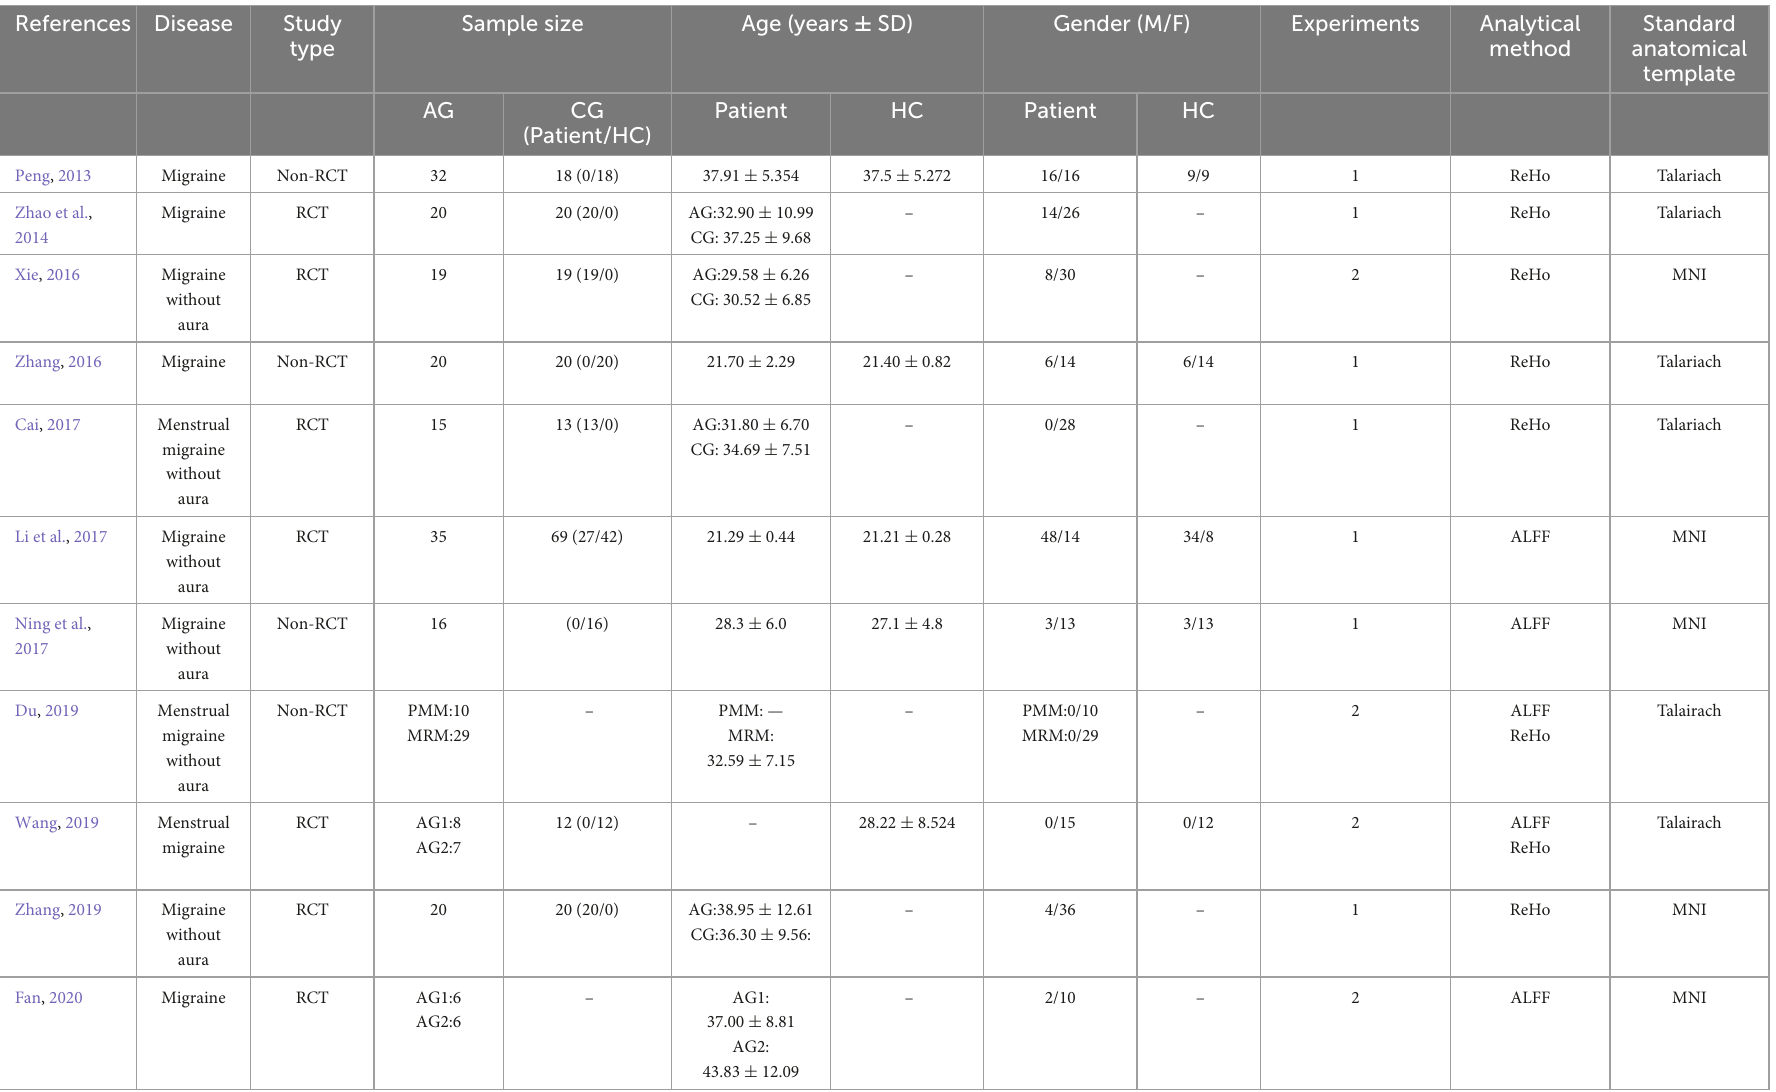
TABLE 1 Characteristics of included